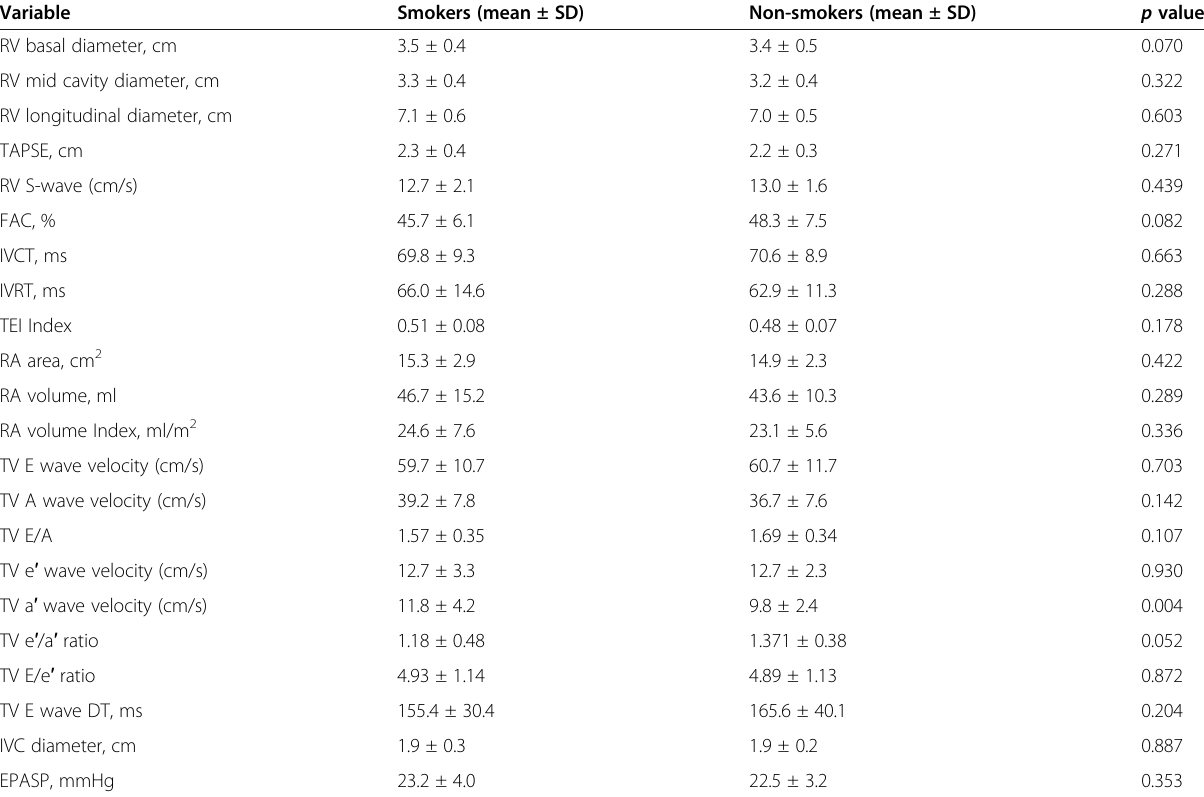
Table 2 Conventional echocardiographic parameters of the systolic and diastolic RV functions of both groups